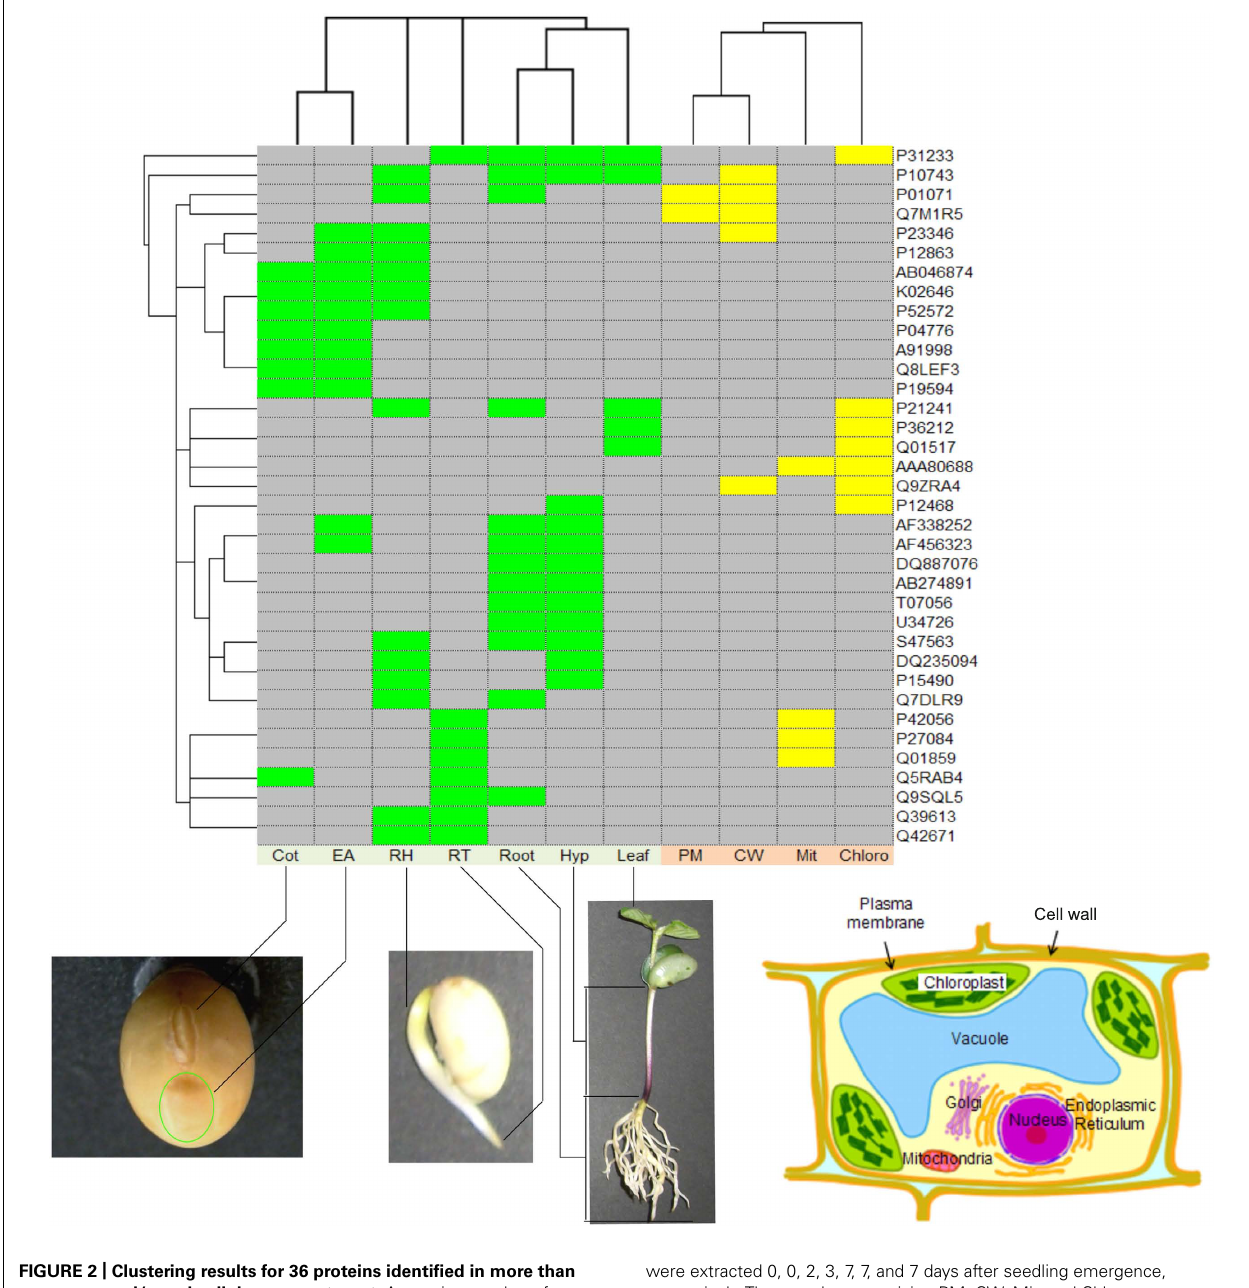
FIGURE 2 | Clustering results for 36 proteins identified in more than one organ and/or subcellular compartment. Accession numbers for the proteins are indicated on the right-hand side. Colored boxes indicate an identified protein found in the organ (green) or a subcellular compartment (yellow). Samples from seven organs, Cot (cotyledon), EA (embryonic axis), RH (radicle plus hypocotyl), RT (root tip), Root, Hyp (hypocotyls), and Leaf, and four subcellular compartments, PM (plasma membrane), CW (cell wall), Mit (mitochondrion), and Chloro (chloroplast), were investigated.The samples of Cot, EA, RH, RT, Root, Hyp, and Leaf